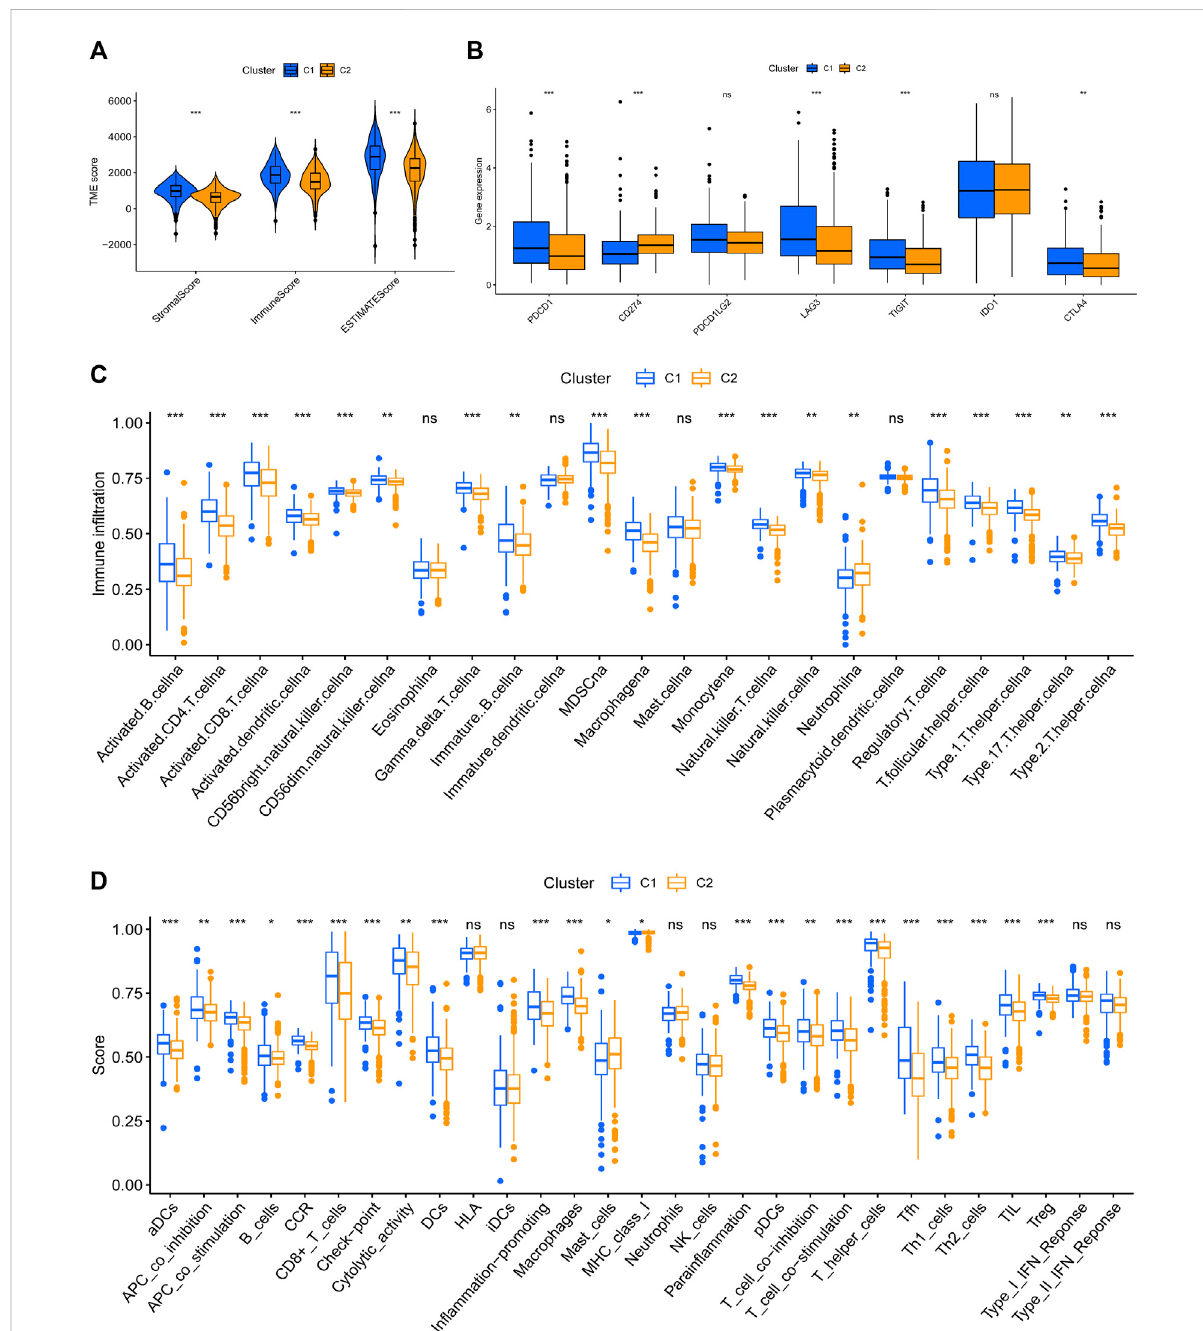
FIGURE 4 Tumor immune microenvironment between cuproptosis-related patterns. (A) The composition of TME in cuproptosis-related patterns. (B) Difference analysis of immune checkpoints expression. (C,D) TIICs-in fi ltrated phenotype (C) and enriched immune functions (D) of cuproptosis- related